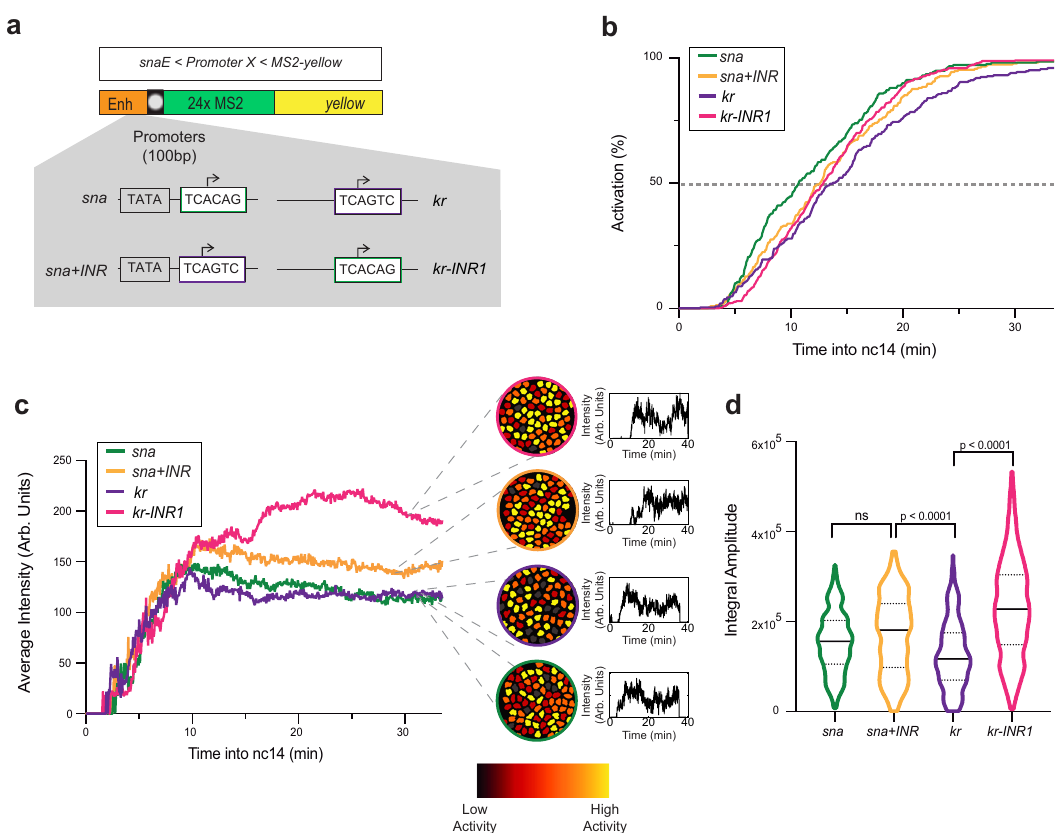
Fig. 5 Decoding the role of the Initiator motif on promoter dynamics. a Schematic of the transgenes used to decipher the impact of the INR motif. The sna core promoter has the TSS region replaced with the INR of kr ( sna + INR ), and the kr core promoter INR motif is replaced with the TSS region of sna ( kr-INR1 ). b Cumulative active nuclei percentage within the mesodermal domain for sna (green), sna + INR (yellow), kr (purple), and kr-INR1 (pink). c Average instantaneous fl uorescence of transcriptional foci of active nuclei during the fi rst 30min of nc14 for sna (green), sna + INR (yellow), kr (purple), and kr-INR1 (pink). Time zero is from anaphase during nc13-nc14 mitosis. False-colored panels on right are colored according to instantaneous fl uorescence intensity with inactive nuclei in gray and highly active nuclei in yellow. d Distribution of individual trace integral amplitudes from fi rst 30min of nc14 for sna (green), sna + INR (yellow), kr (purple), and kr-INR1 (pink). The solid line represents the median, and dashed lines represent the fi rst and third quartiles, using a one-tailed Kruskal – Wallis test for signi fi cance with multiple comparison adjustments. Statistics: snaE < sna , 216 nuclei, 3 movies; snaE < sna + INR , 236 nuclei, 4 movies; snaE < kr , 243 nuclei, 4 movies; snaE < kr-INR1 , 342 nuclei, 5 movies. See Supplementary Movies 1, 4 –